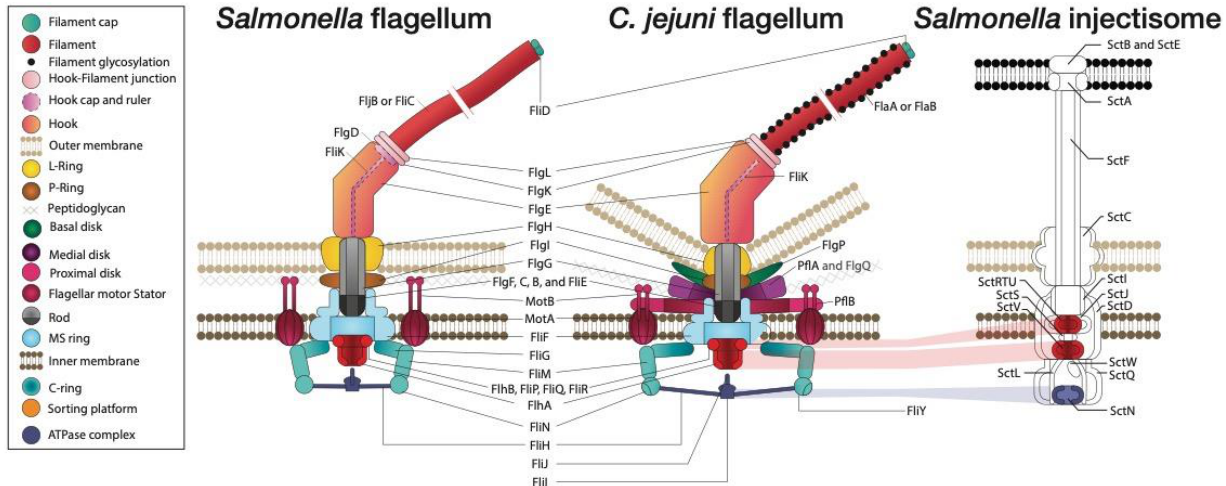
Figure 3. Comparison of the flagellum and injectisome of Salmonella to the flagellum of C. jejuni . The central panel depicts the C. jejuni flagellum based on current knowledge. C. jejuni proteins sharing significant homology with Salmonella flagellar proteins are indicated between the left panel, illustrating Salmonella’s flagellum, and the central panel. The flagellar proteins that do not share significant homologies or are unique to the bacterial isolate are individually annotated. The right panel shows the proteins of the Salmonella type III secretion system that share homology with the C. jejuni flagellar secretion system apparatus. The shading between the two panels indicates the existence of homologies.